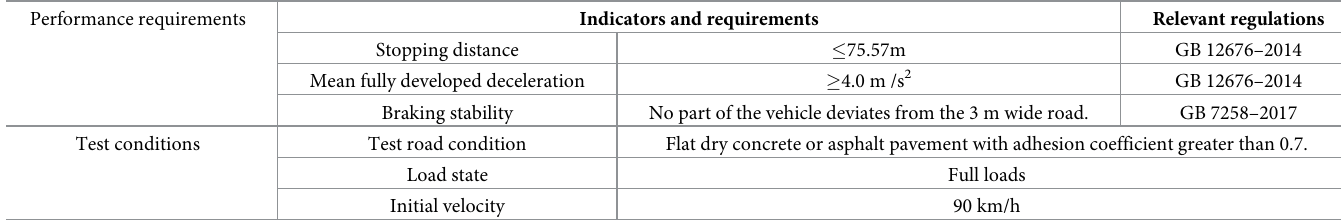
Table 4. The braking efficiency and stability requirements of the M3 vehicles.